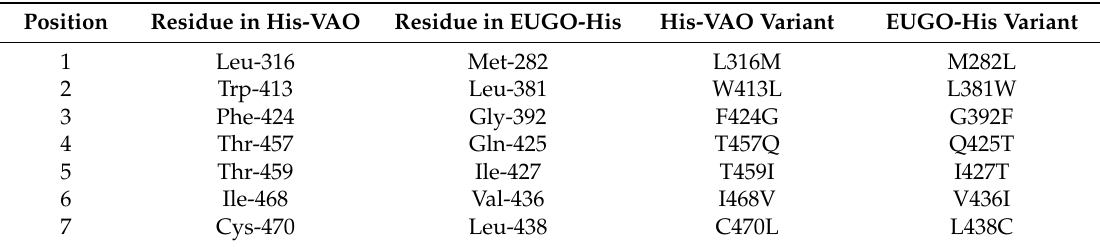
Figure 3. Structures of the substrate-binding pockets of vanillyl alcohol oxidase (VAO) and eugenol oxidase (EUGO) with the competitive inhibitor isoeugenol bound. Structures are shown in stick representation with residues that are identical in each protein shown in grey, residues that are different in each protein shown with green (VAO) or cyan (EUGO) carbon atoms, the FAD cofactor shown with yellow carbon atoms and isoeugenol shown with magenta carbon atoms. The VAO and EUGO structures were downloaded from the PDB website (PDB identifiers: 2VAO [8] and 5FXD [9] respectively). Figure was prepared using PyMOL v. 1.3 (Schrödinger LLC, New York, NY, USA). Table 4. List of residues forming part of the substrate-binding pocket that are different in vanillyl alcohol oxidase (VAO) and eugenol oxidase (EUGO) and of the His-tagged vanillyl alcohol oxidase (His-VAO) and His-tagged eugenol oxidase (EUGO-His) variants that were made during this study. The residues are numbered according to their position in the non-His-tagged wild-type